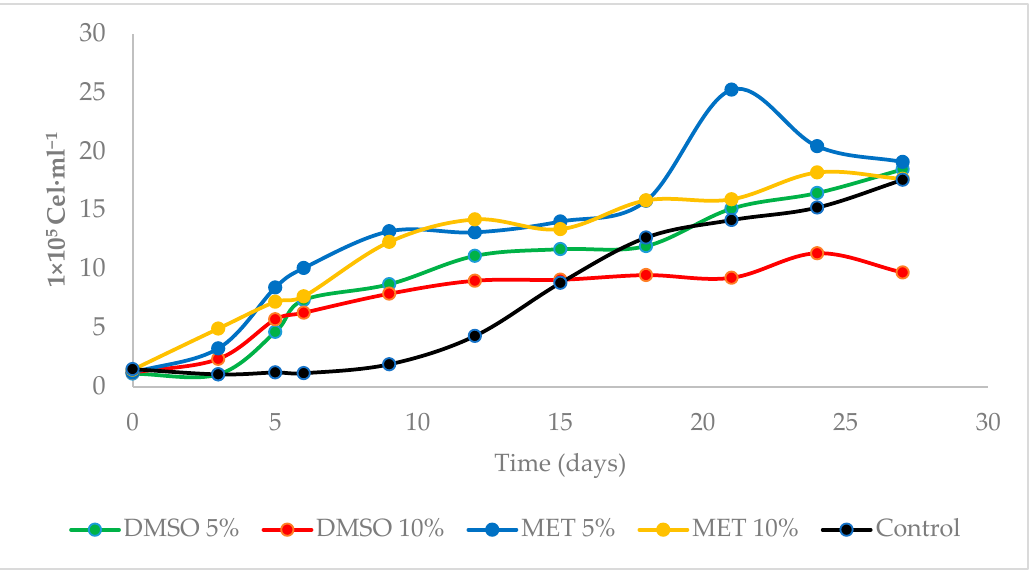
Figure 4. Adjusted population growth curve/real post-thawing of Scenedesmus sp., throughout the 27 days of cultivation.